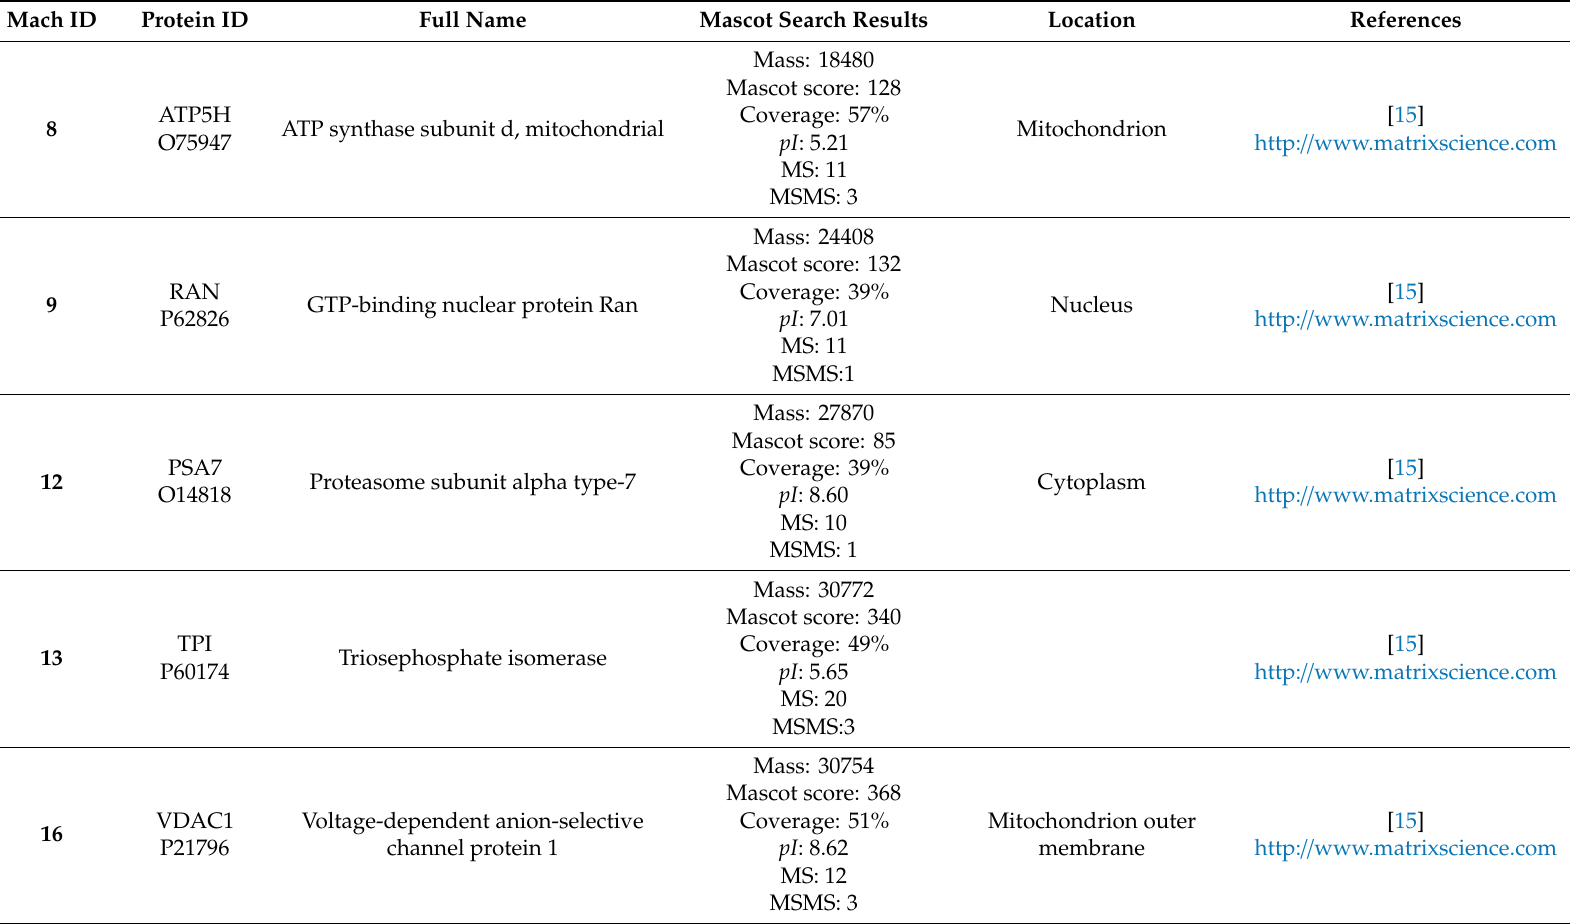
Table 9. Characteristics of proteins that have undergone di ff erential expressions in A2780 and A2780 cisR cell lines following treatment with selected drug combinations using A2780 cisR cell line as